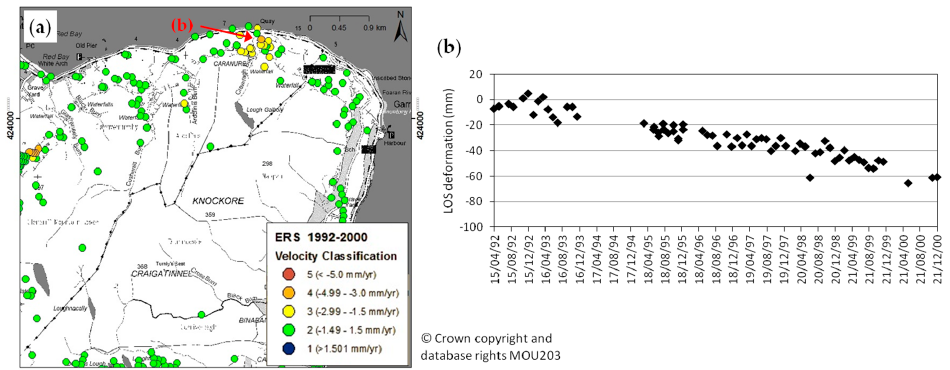
Figure 15. ( a ) Observed ground deformation and ( b ) time series for 1992–2000 in the area of Garron Point. Reproduced from Land and Property Services data with the permission of the Controller